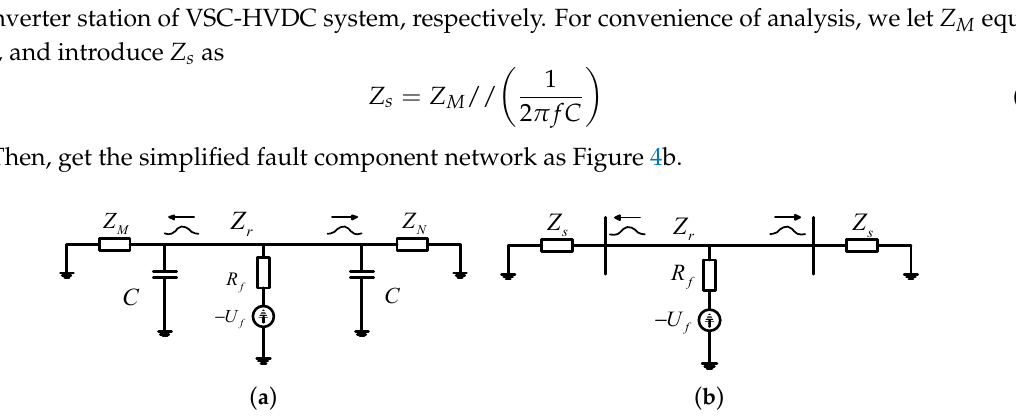
Figure 4. ( a ) Fault component additional network of Voltage Source Converter-High Voltage Direct Current (VSC-HVDC). ( b ) Simplified fault component additional network